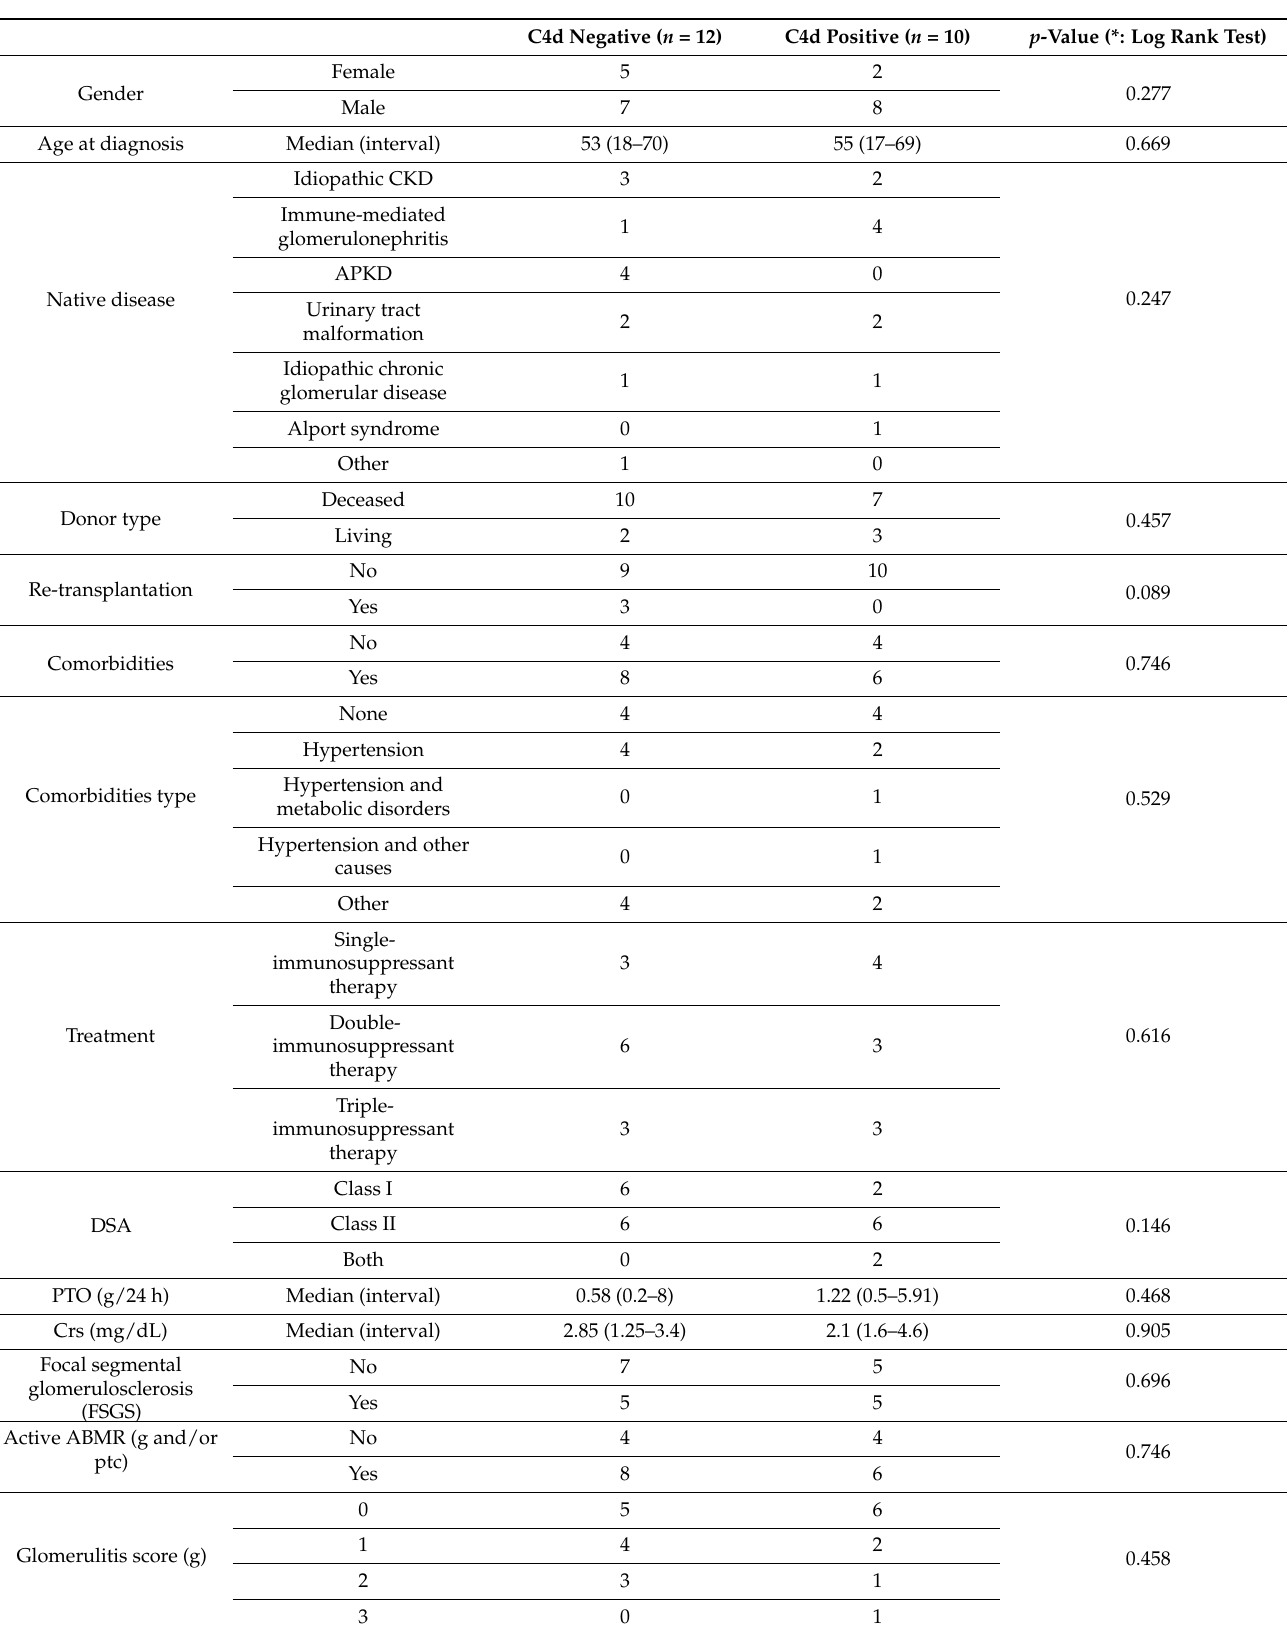
Table 3. Clinicopathological data of C4d positive versus C4d negative cases. CKD: chronic kidney disease; APKD: polycystic kidney disease; PTO: proteinuria; Crs: creatininemia; g: glomerulitis; ptc: peritubular